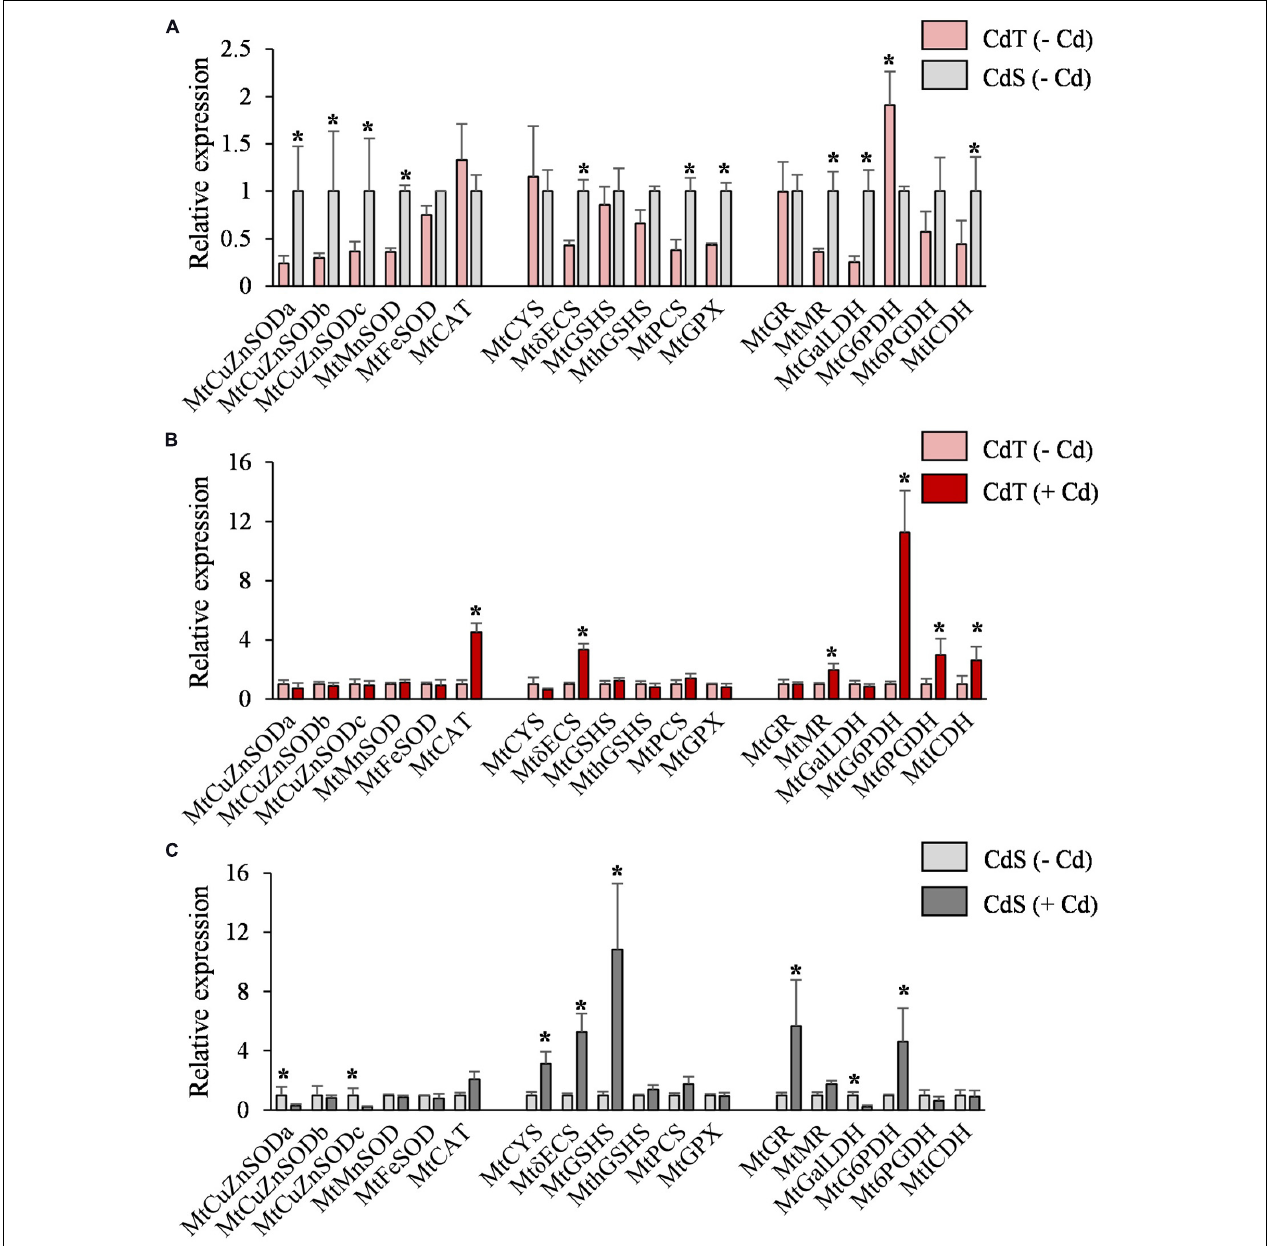
FIGURE 6 | Transcript accumulation of genes involved in the antioxidant machinery and NADPH biosynthesis in seedling roots of M. truncatula cultivars CdT (tolerant) and CdS (sensitive) grown in glass containers in the absence or presence of 50 µ M CdCl 2 for 12 h. (A) Transcript accumulation for CdT and CdS in absence of Cd. (B) Effect of Cd on transcript accumulation in CdT roots. (C) Effect of Cd on transcript accumulation in CdS roots. Mean values ± standard deviation are represented ( n = 4). * Denotes fold-changes greater than